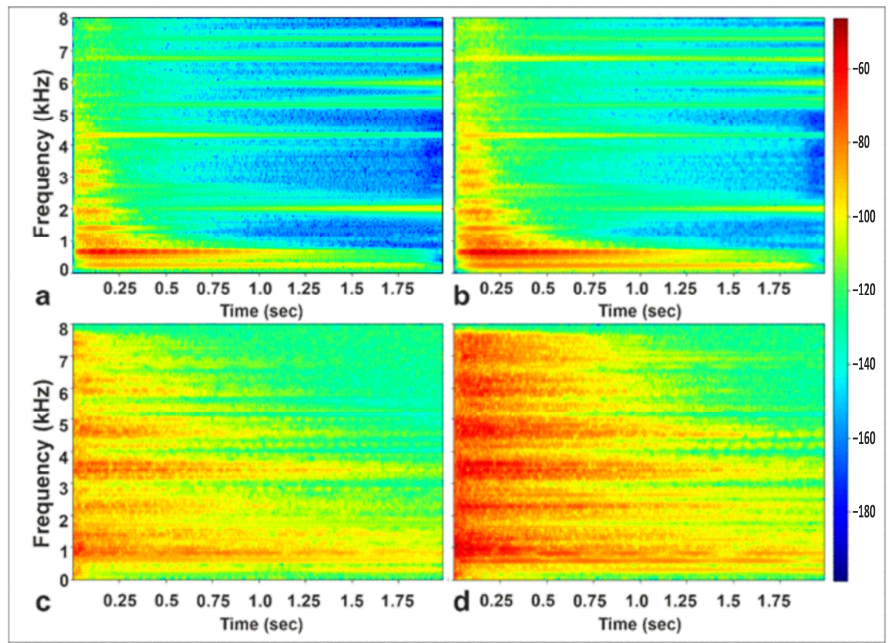
Figure 7. Time domain FEM-BEM results of pressure spectrograms for the splash cymbal hit by ( a ) a p free stroke and ( b ) a ff free stroke and recorded sound results of the cymbal, for the same ( c ) p free stroke and ( d ) ff free stroke.